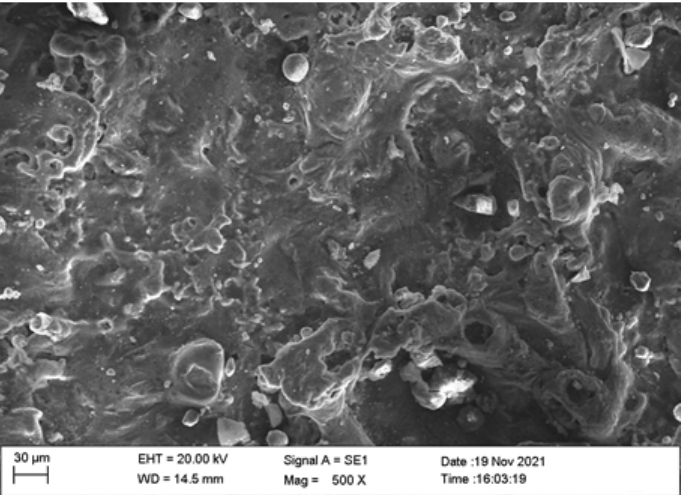
Figure 21. Morphology of machined